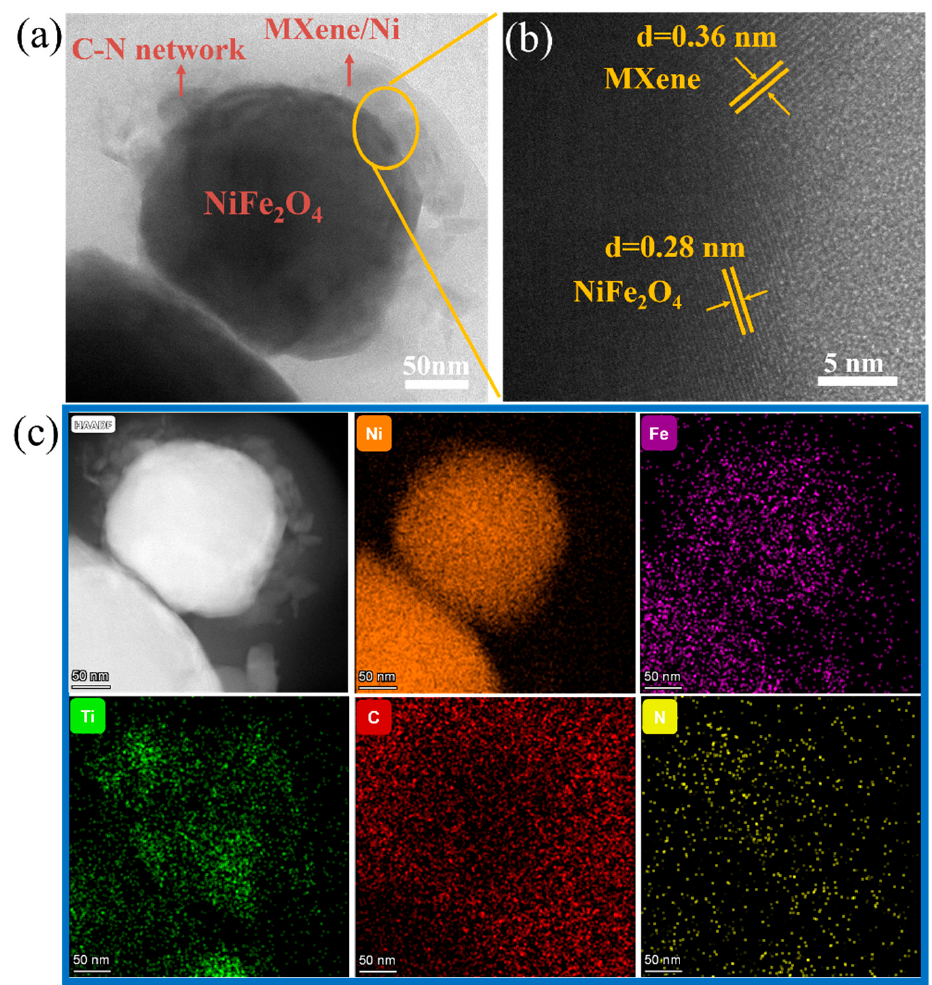
Figure 3. ( a ) TEM image of C-N@NM; ( b ) HRTEM image of C-N@NM; ( c ) STEM and corresponding elemental mapping images of C-N@NM.